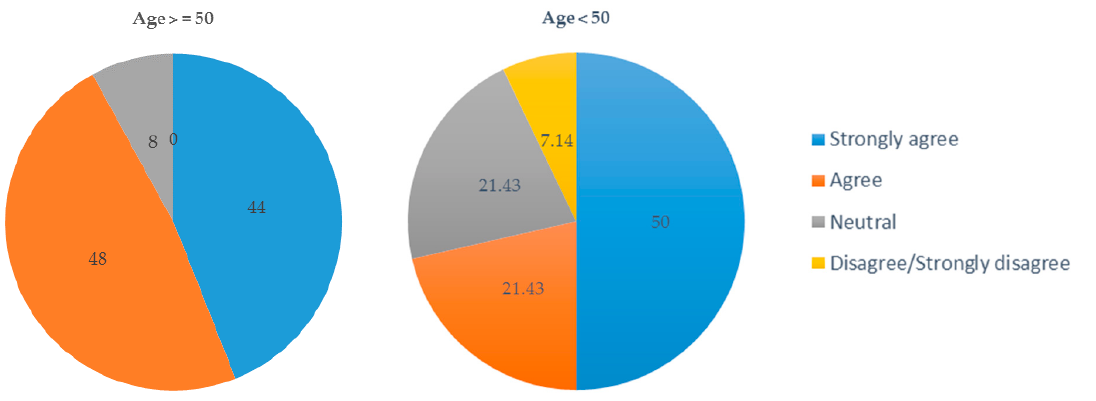
Figure 1. Home care aides’ stretching or strengthening time spent in the last week.